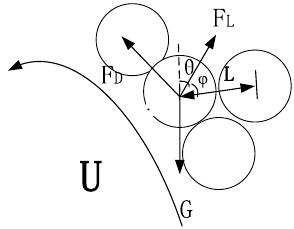
Figure 3. The force analysis of particles in the slurry.